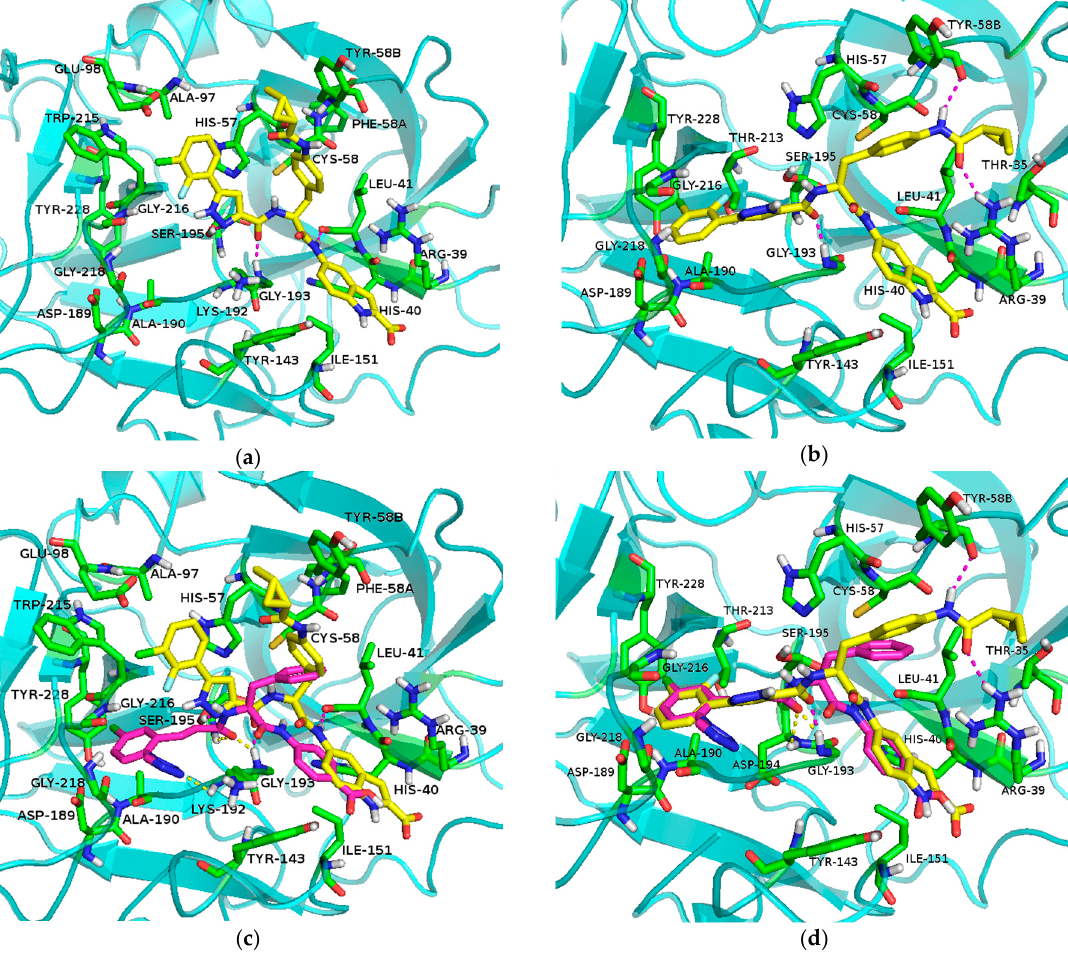
Figure 5. ( a ) Molecular model 1 of 7za in active site of FXIa; ( b ) Molecular model 2 of 7za in active site of FXIa; ( c ) Superposition of molecular mode 1 of 7za with compound 3 ( 7za : yellow, compound 3 : purple); ( d ) Superposition of molecular mode 2 of 7za with compound 3 ( 7za : yellow, compound 3 : purple).